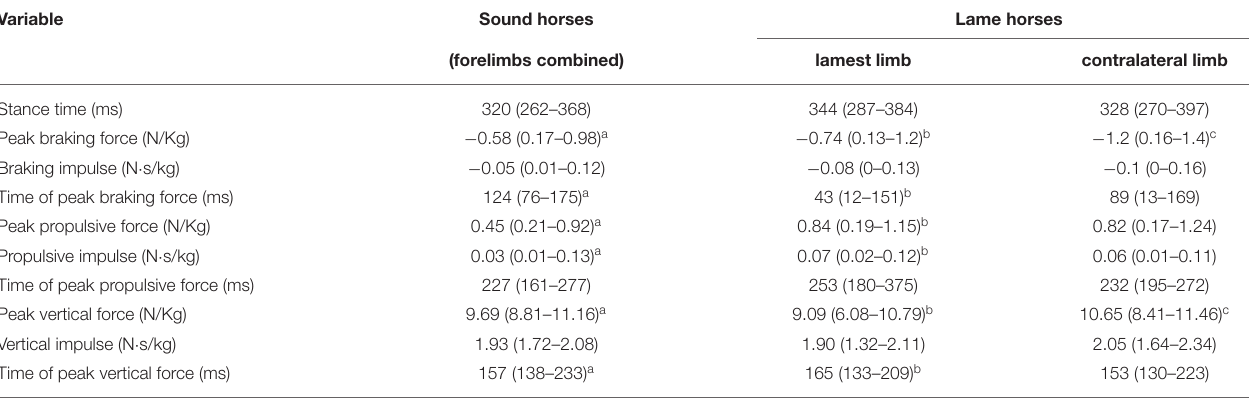
TABLE 2 | Median and range forelimb kinetic gait variables obtained from 11 lame horses and 5 healthy sound horses during force plate trials (10 trials/horse) performed with the horses barefoot.